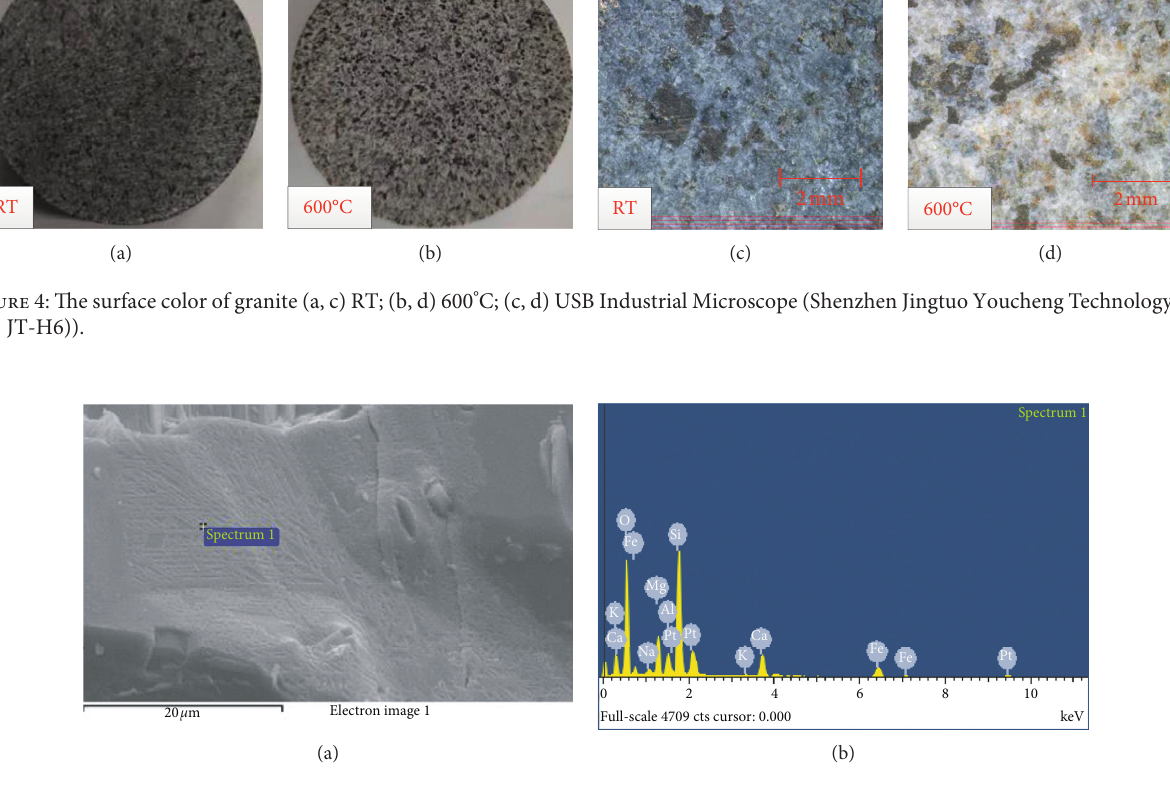
Figure 5: The result of energy-dispersive spectroscopy (EDS). Table 2: XRD analysis